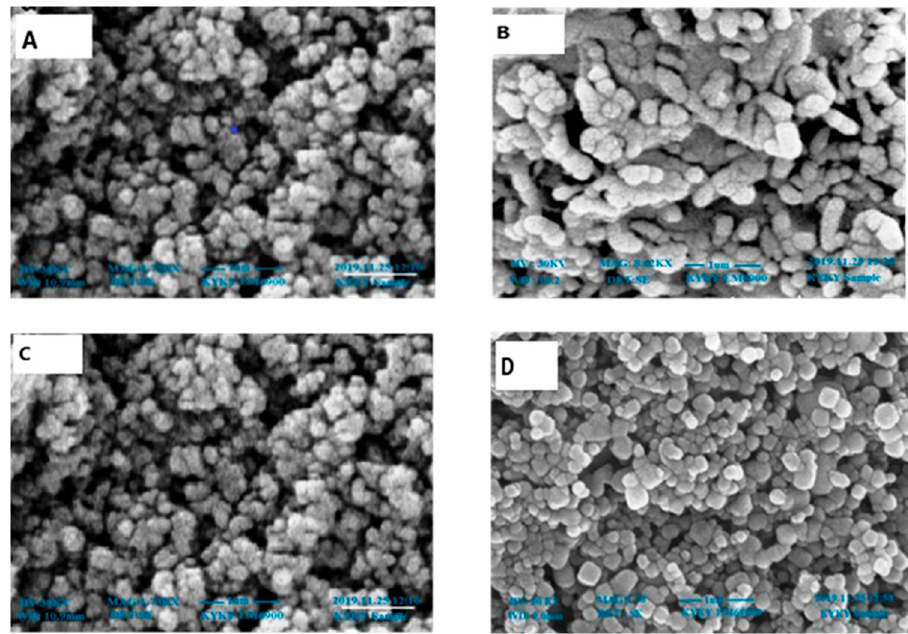
Figure 3. SEM images of zinc oxide nanoparticles of leaves: ( A ) n-hexane, ( B ) ethyl acetate, ( C ) methanol, and ( D ) aqueous extracts.